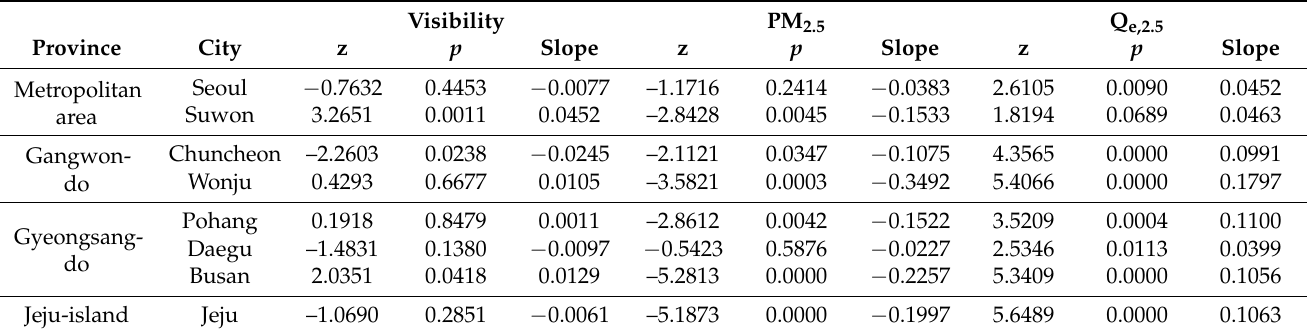
Table 7. MK Test and Sen’s slope for monthly trends of PM 2.5 , Q e,2.5 during 2015–2020 (clear trend with 95% CL for |z| > 1.96 and 99% CL for |z| > 2.57).